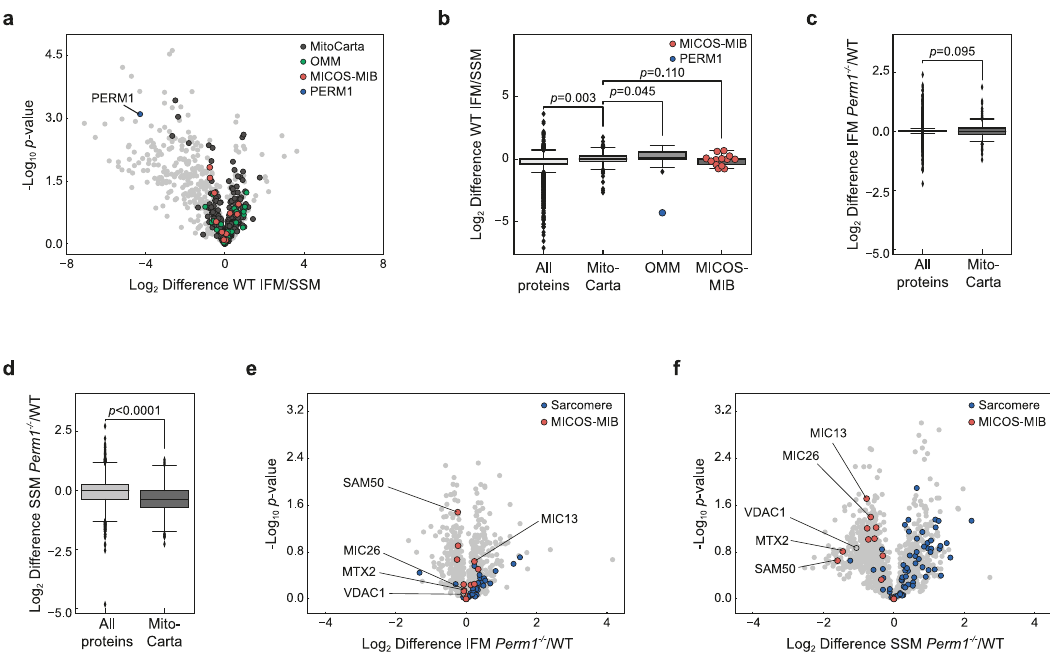
Fig. 2 PERM1 is speci fi cally enriched in SSM, and SSM are altered in Perm1 − / − muscles. a , b Volcano plot ( a ) and boxplot ( b ) depicting the regulation of PERM1, MitoCarta-annotated, OMM, and MICOS – MIB proteins in isolated IFM and SSM from wild-type TA muscle. Mitochondrial and OMM proteins are enriched in IFM. Inversely, PERM1 is clearly more abundant in the SSM fraction ( n = 3 mice per group). c , d Comparison of log 2 differences in MitoCarta 2.0 proteins compared to the complete dataset revealed no changes in the overall regulation of mitochondrial proteins in ( c ) isolated IFM of Perm1 − / − TA muscle compared to wild-type control, though MitoCarta-annotated proteins were signi fi cantly reduced in ( d ) isolated SSM from Perm1 − / − TA muscle compared to wild-type control ( n = 3 mice per group). e , f ) Volcano plots highlighting the regulation of sarcomeric proteins and proteins of the MICOS – MIB complex in ( e ) isolated IFM from Perm1 − / − TA compared to wild-type control and in ( f ) isolated SSM from Perm1 − / − TA compared to wild- type control ( n = 3 mice per group). Box plots ( b , c , d , e ) represent the median, 25th, and 75th percentiles, maximum and minimum are connected